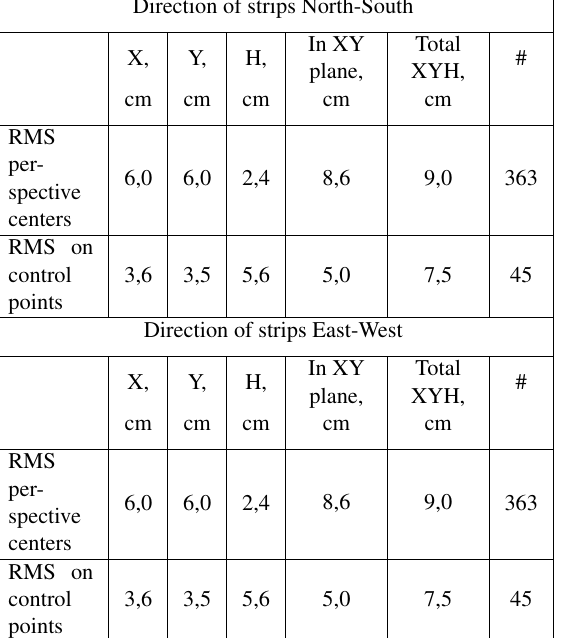
Table 3. Results of check adjustment of photogrammetric network separately in the directions of strips with self-calibration without use of control points.